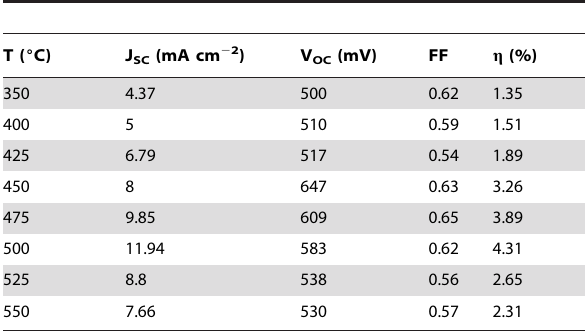
Table 1. DSC efficiencies recorded for various FTO doping levels achieved by modifying the sintering temperature